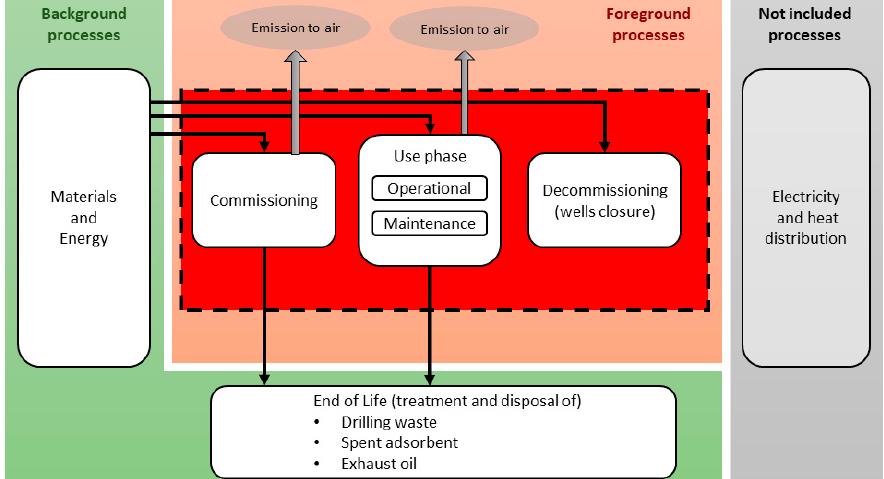
Figure 1. Graphical representation of the system boundaries considered in this study. A distinction is made between background processes that use secondary data (Ecoinvent database v3.5) and foreground processes that use primary data representative of the Bagnore power plant system. Electricity and heat distribution infrastructure and processes are not included in this study.